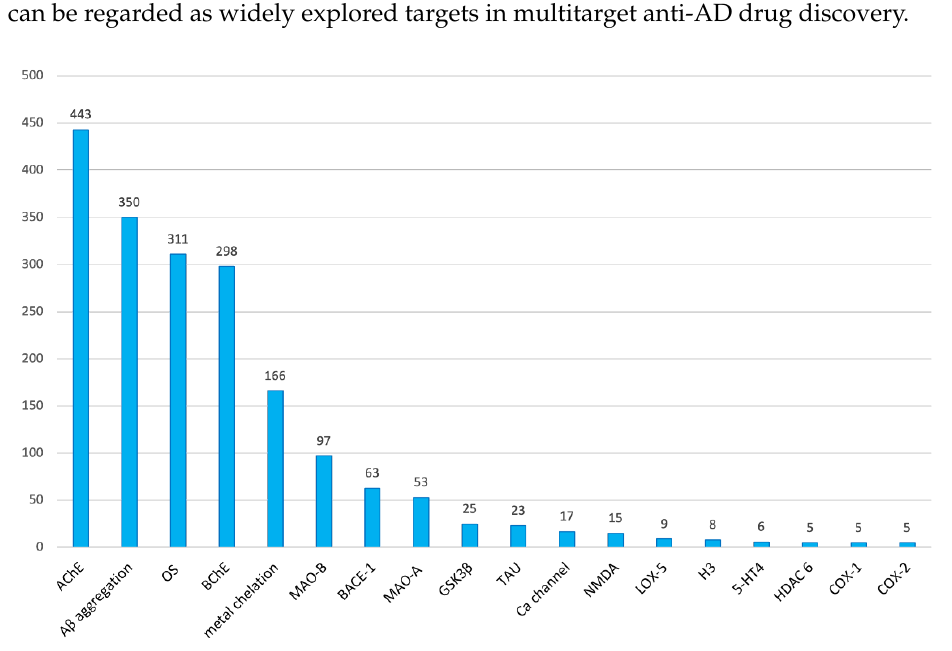
Figure 7. Biological targets that have been pursued in 5 or more research articles on multitarget anti- AD compounds in the period 1990–2020 and number of articles in which they have been